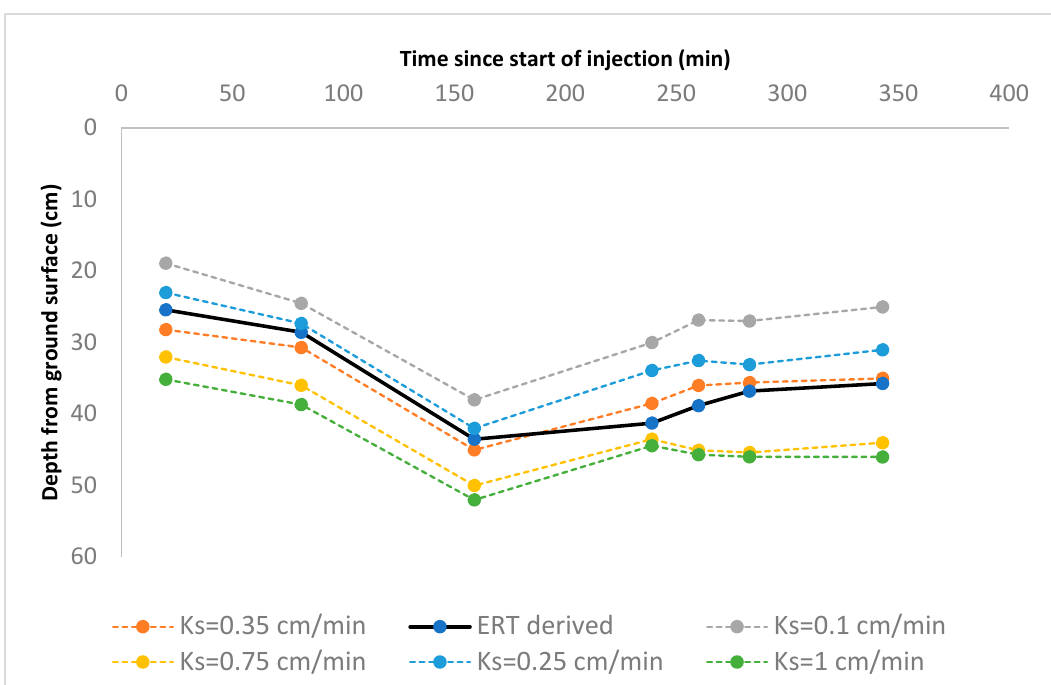
Figure 7. Comparison between the depth of the mass center estimated from ERT and simulations.